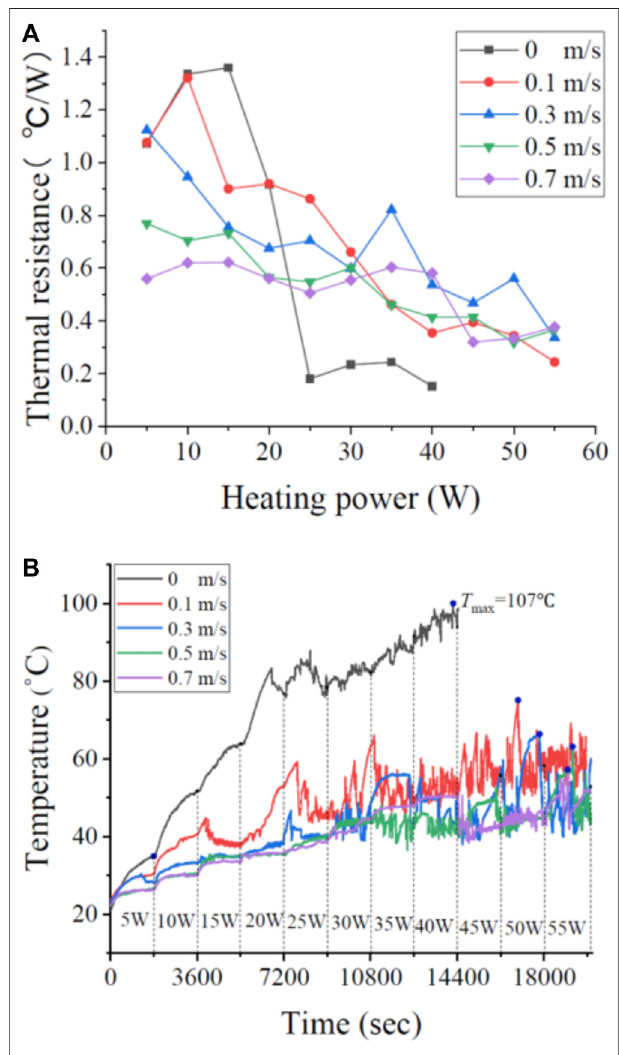
FIGURE 11 | (A) Thermal resistance and (B) average temperature in the evaporation section with different wind speeds for the PHP CPU cooler (Shang et al.,